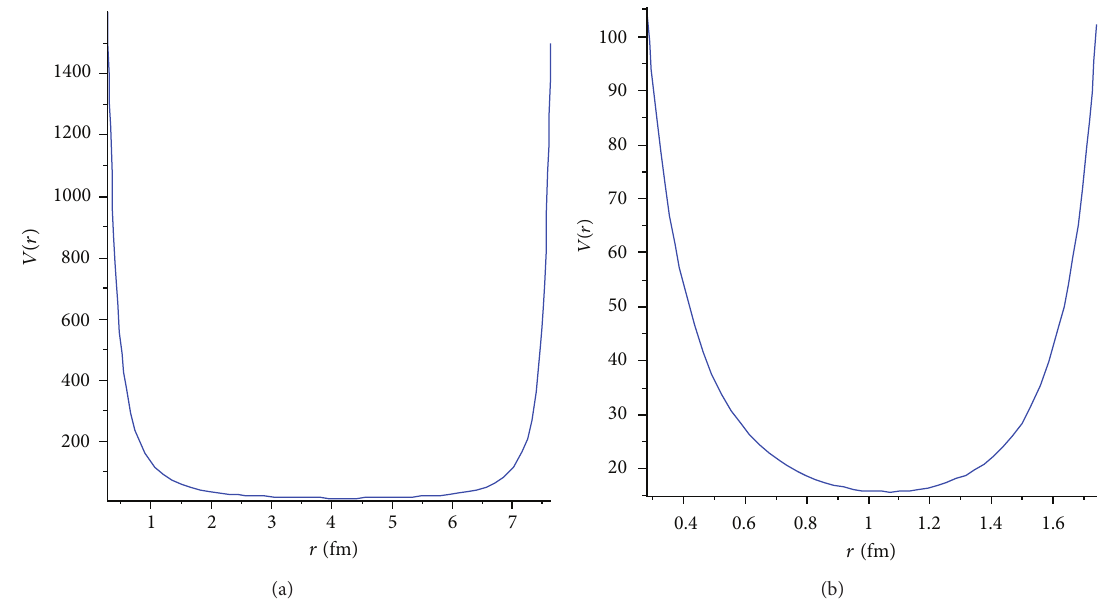
Figure 1: (a) A plot of the tPT potential for 𝛼 = 0.2 fm −1 . (b) A plot of the tPT potential for 𝛼 = 0.8 fm −1